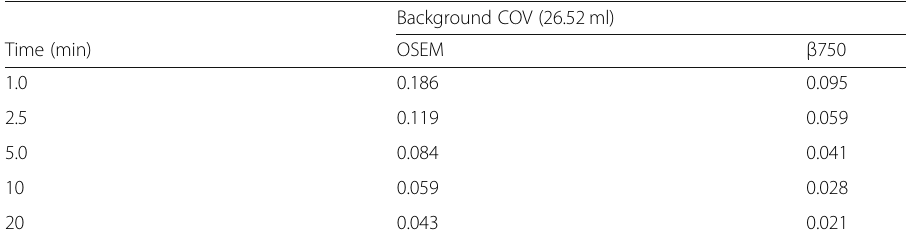
Table 2 Comparison in terms of background COV between TOF-OSEM (3 iterations, 16 subsets, post-filter 5.0 mm and PSF) and BSREM with β = 750 for a volume of 26.52 ml at different count statistics. All values correspond to a contrast ratio of 8:1